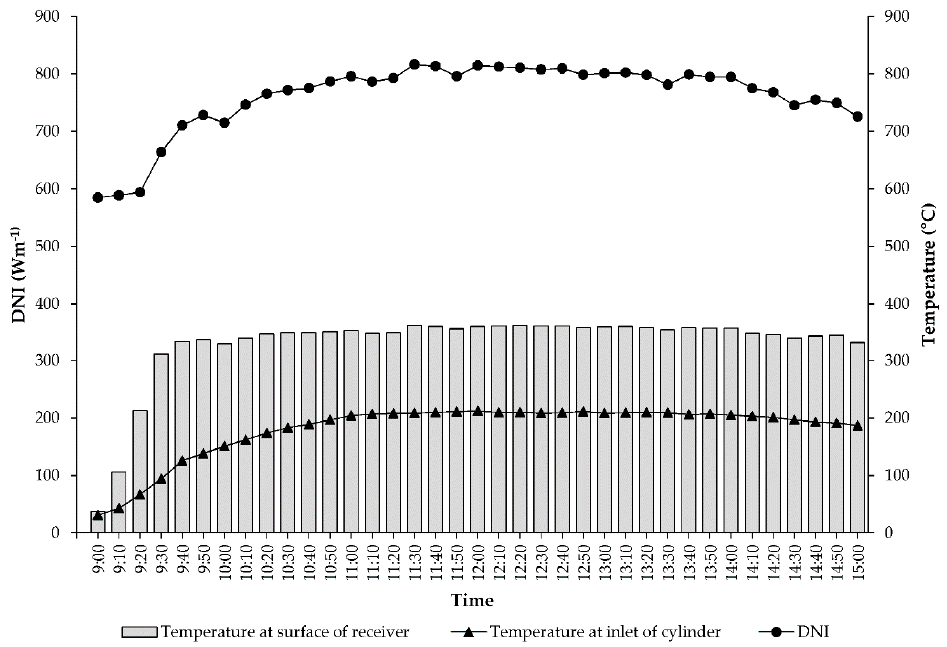
Figure 8. Variation in inlet temperature of roasting cylinder vs DNI.